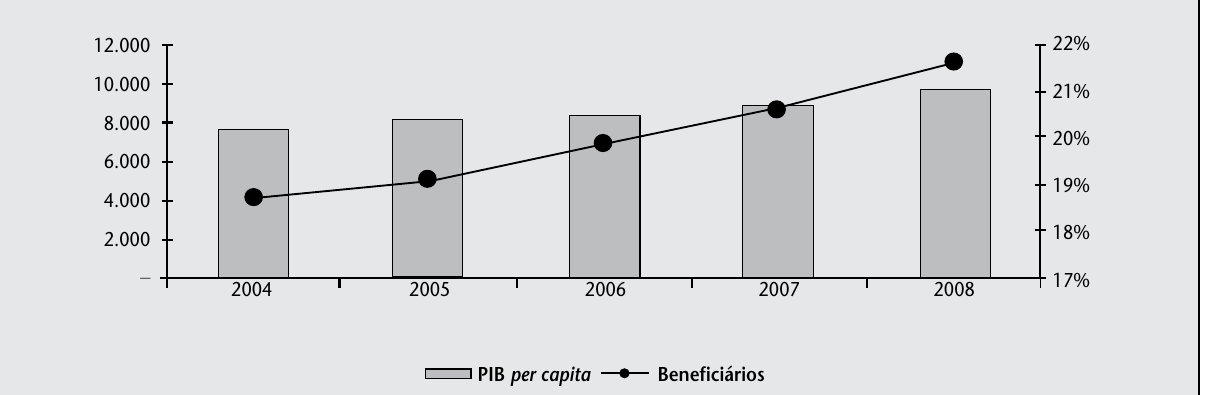
Figura 2 – PIB per capita e beneficiários de OPAS (2004 a 2008) PIB: produto interno bruto; OPAS: Organização Pan-Americana da